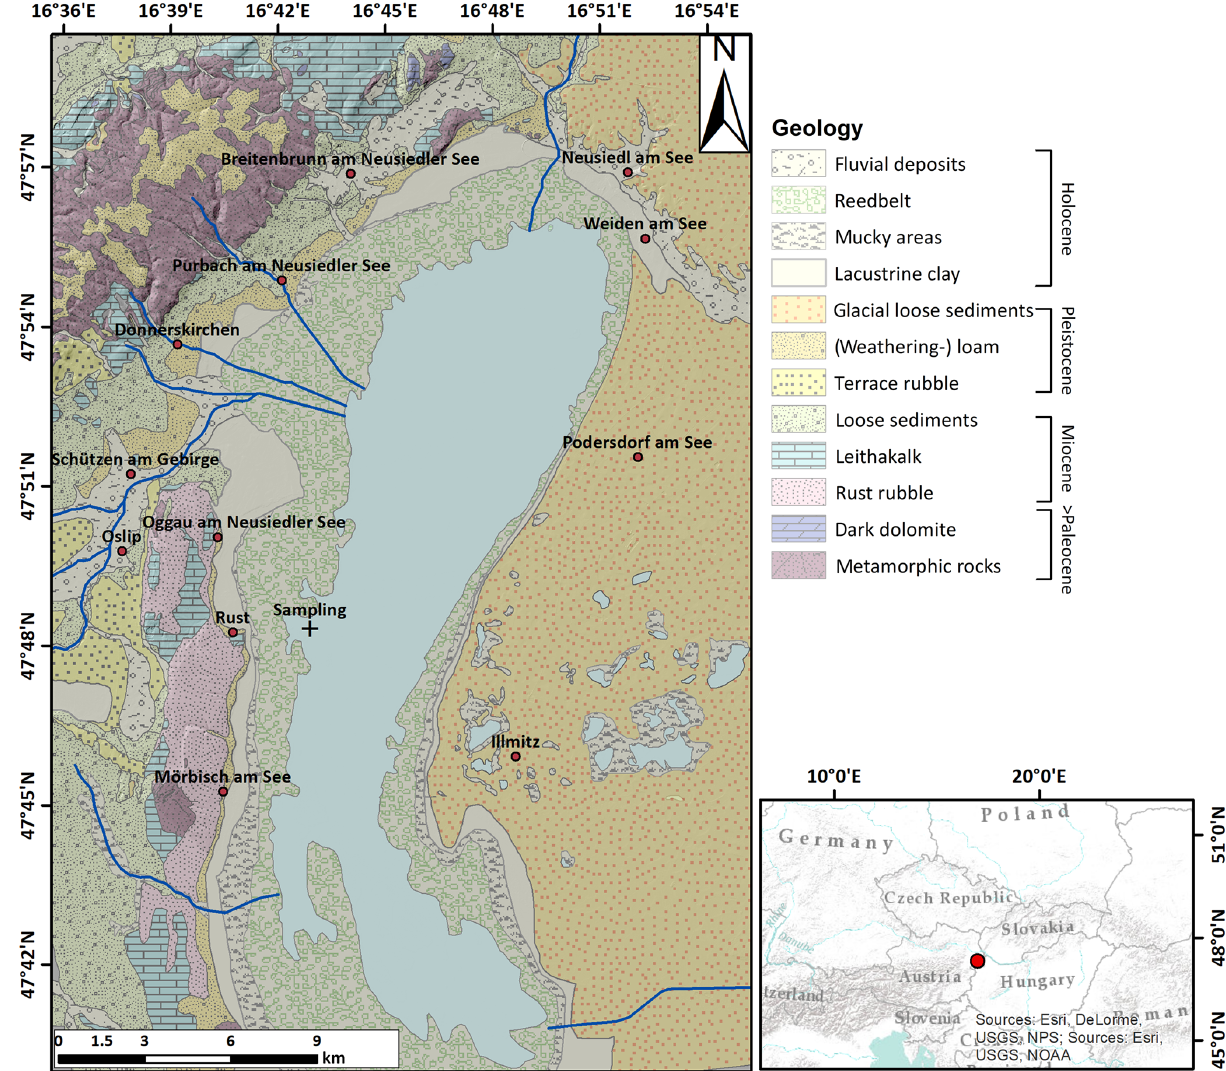
Figure 1. Lake Neusiedl and its surrounding geology, redrawn and simplified after Herrman et al.